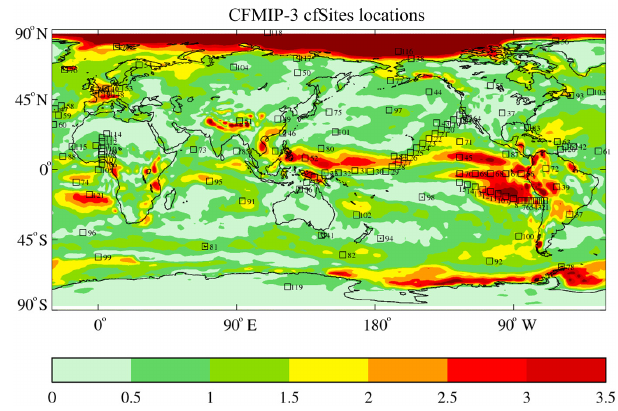
Figure 2. CFMIP-3/CMIP6 cfSites locations. The contours give an indication of inter-model spread in cloud feedback from the CFMIP-2/CMIP5 amip/amip4K experiments (please refer to Webb et al., 2015a, for